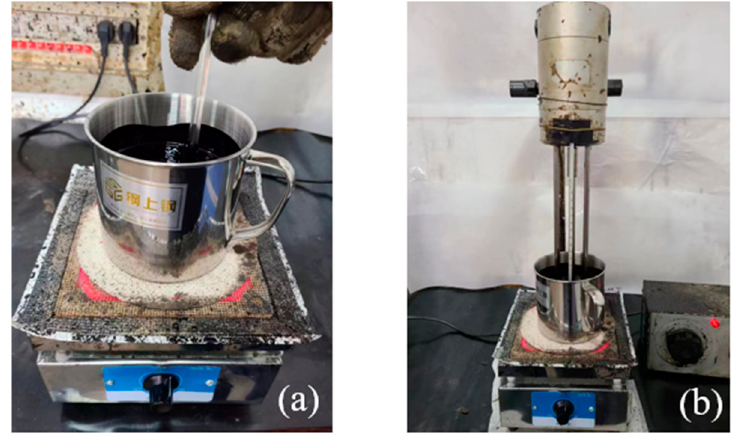
Figure 3. ( a ) Manually stirred process of STPU and NA. ( b ) High-speed mixer blending STPU and NA.